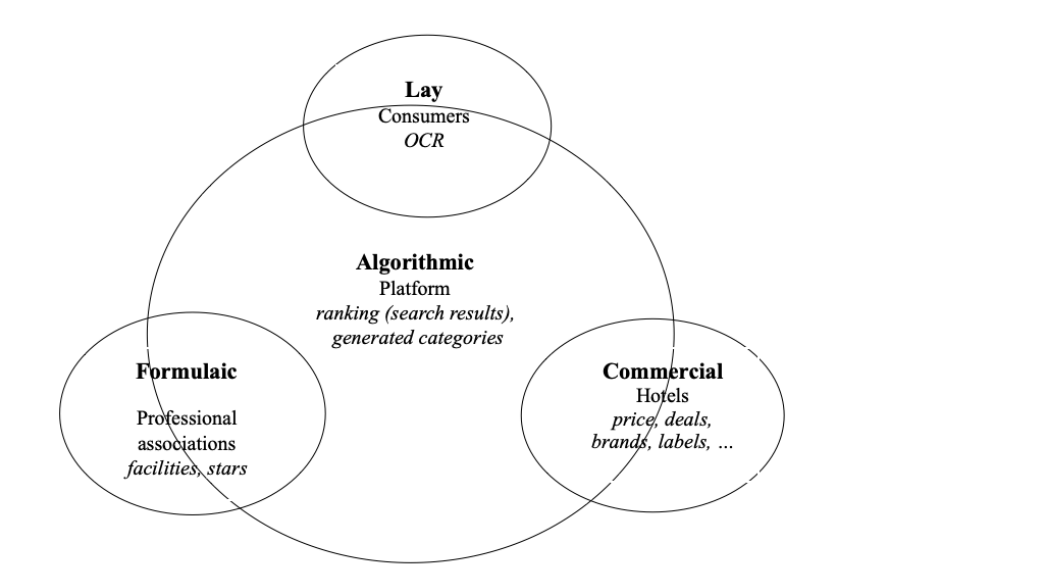
Figure 2. Valuation poles on Booking.com’s evaluative infrastructure. Source: Authors’ own